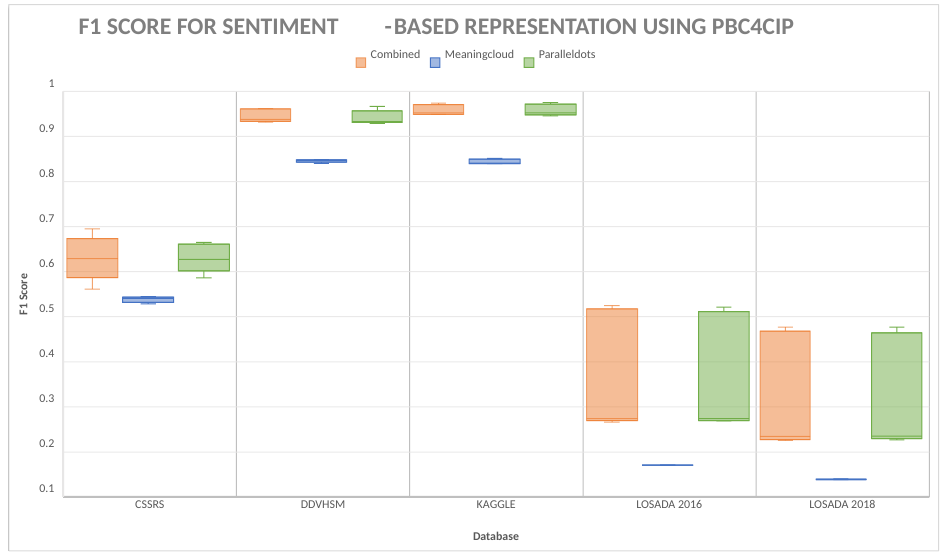
Figure 2. A comparison plot of the F1 score for the proposed sentiment-based representations using PBC4cip.